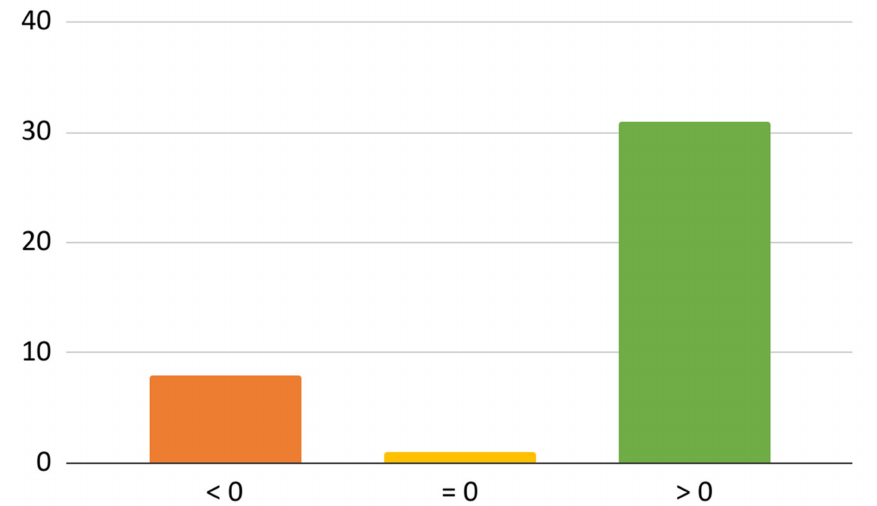
Figure A3. The number of patients who decreased the extent of painless mandibular abduction (<0), the extent of painless mandibular abduction did not change (=0), and the extent increased (<0) based on differences in treatment outcomes.